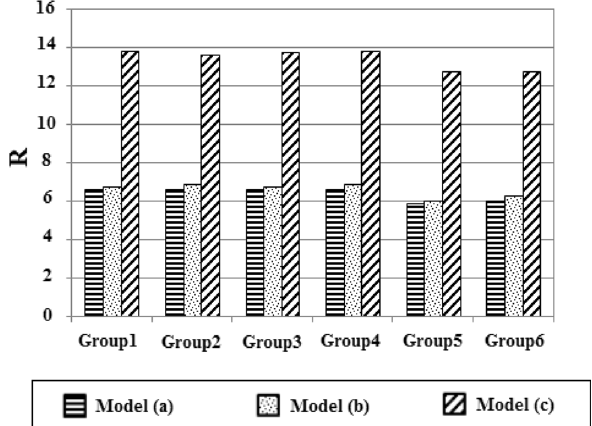
Fig. 20 Computational ratio of the response modification factors of models with x-diagonals to those of models with a Vierendeel